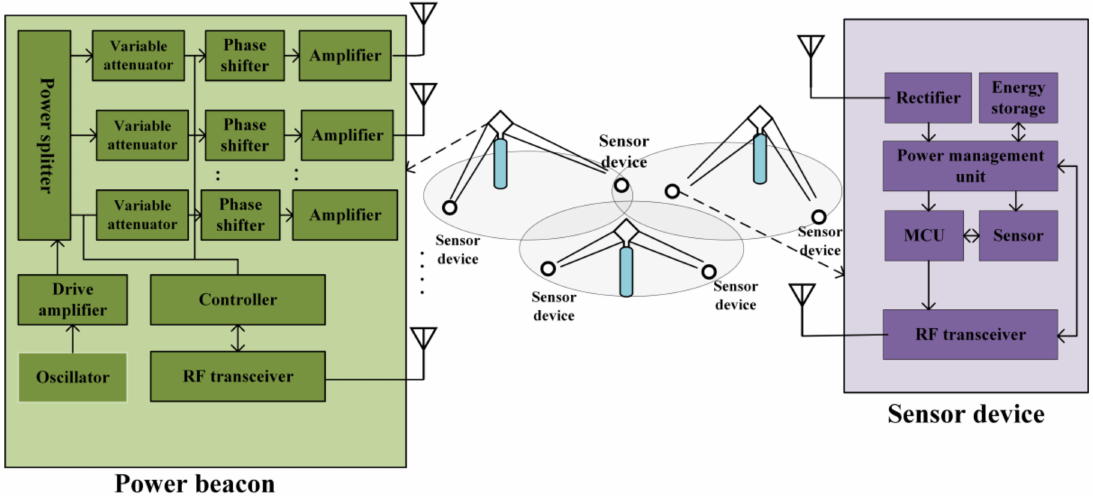
Figure 3. Basic architecture of a wireless-powered sensor